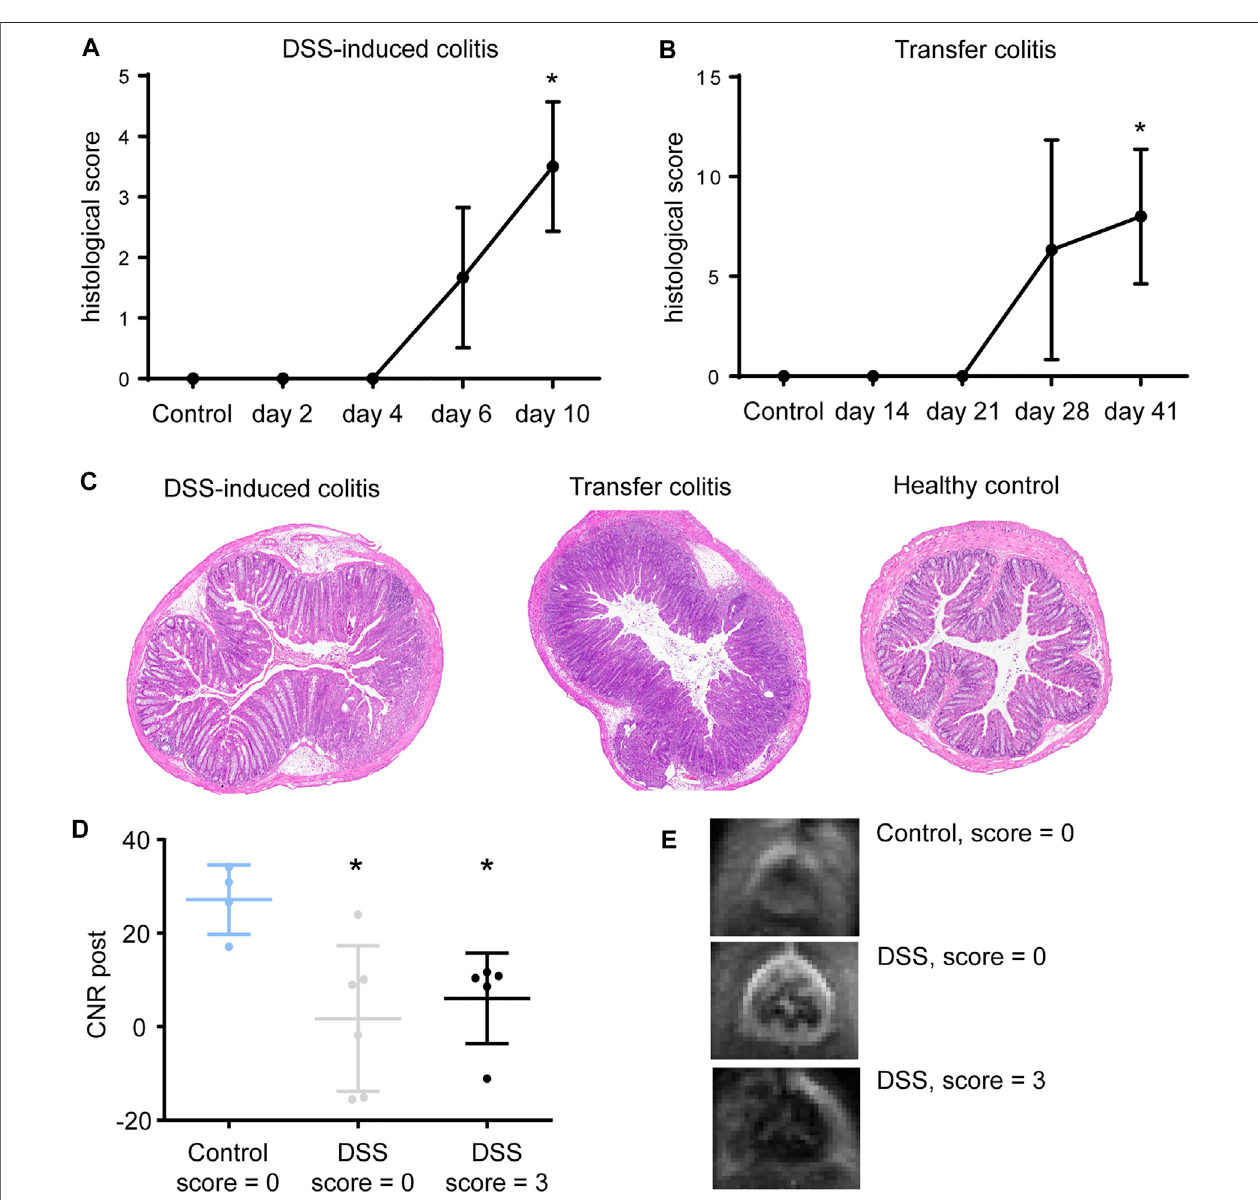
FIGURE 2 | CNR decrease in histologically non-in fl amed colon tissue. (A) Mice with DSS-induced colitis presented with an increased score starting at day 4 (mean ± SD, n = 2 – 6) when compared to controls ( n = 3) Statistical signi fi cance was tested with Mann-Whitney test (non-parametric t -test) with p ≤ 0.05 de fi ning the statistical signi fi cance that is marked with *. (B) Transfer colitis mice show increase in histopathological in fl ammation score starting at day 21 (mean ± SD, n = 2 – 4) comparedtocontrols( n =4).Statisticalsigni fi cancewastestedwithMann-Whitneytest(non-parametric t -test)with p ≤ 0.05de fi ningthestatisticalsigni fi cancethat is marked with *. (C) Representative images of H&E-stained colon sections of DSS-induced colitis mouse at day 10 with manifestation of severe ulceration and tissue changes, transfer colitis mouse showing severe crypt hyperplasia and immune cell in fi ltration and healthy control mouse. (D) CNR in position one of colon MRI of DSS- treatedanimalswithhistologicalscoreof0and3withrespectivecontrol(mean±SD, n =5 – 6).Animalsshowedasigni fi cantlylowerCNR(CNRpost)whenscoredwith0 ( p =0.019)or3( p =0.0159)whencomparedtoCNRofthehealthycontrolgroup.Statisticalsigni fi cancewastestedwithMann-Whitneytest(non-parametric t -test)with p ≤ 0.05 de fi ning the statistical signi fi cance that is marked with p . (E) Representative images at position one of colon regions (distal colon) where no signal loss was observed in the colon wall of healthy animals, but severe signal loss in DSS-induced colitis mice with histology score of 0 or 3.